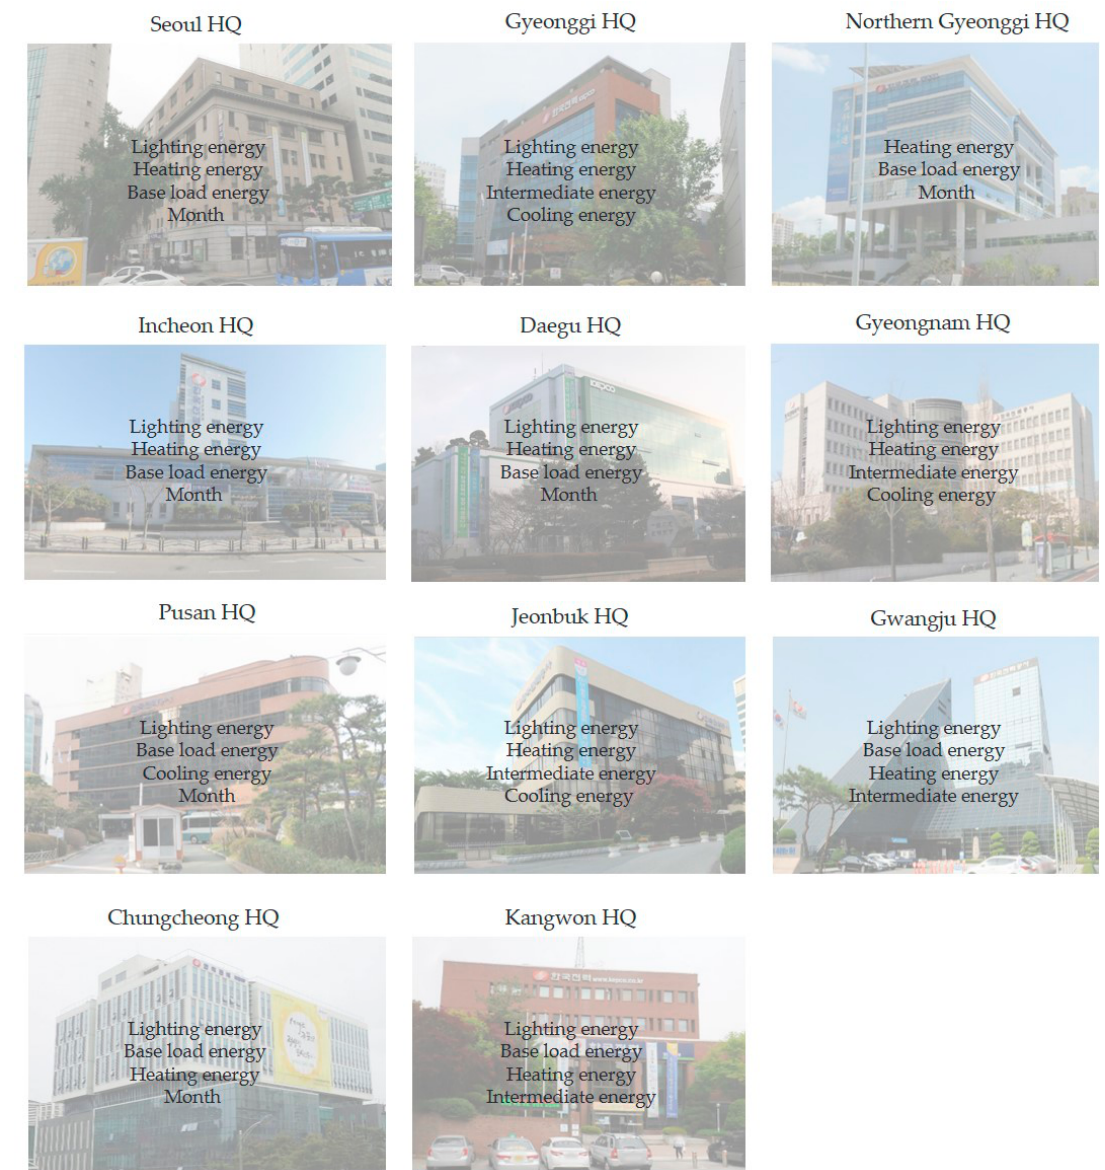
Figure 7. Results of the clustering of 11 regions and important variables.